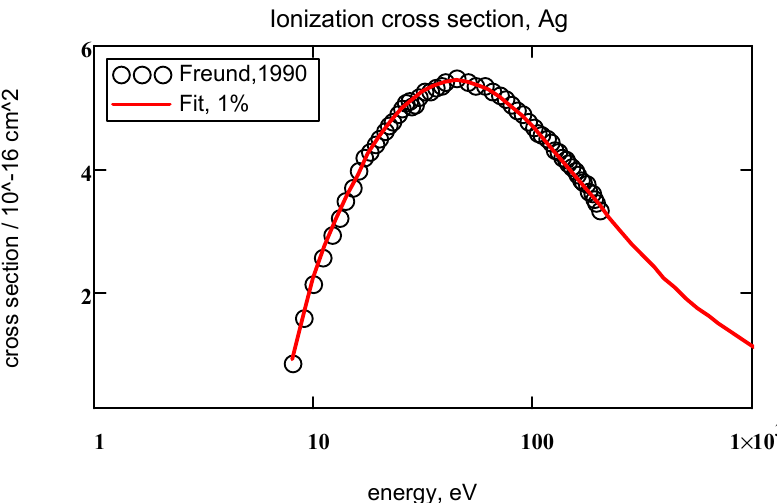
Figure 1. The experiment [10] and the result of approximation by the one − term Formula (6) of the ionization cross section of silver atoms with a mean-square relative error of 1.0%.